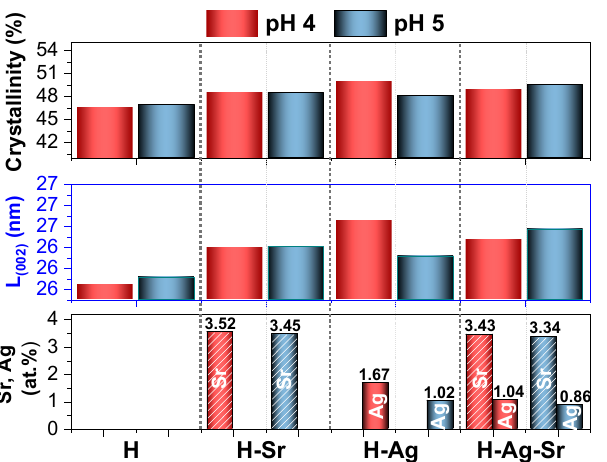
Figure 5. Correlation between crystallite dimension, crystallinity and at.% of Sr and/or Ag in the coatings.